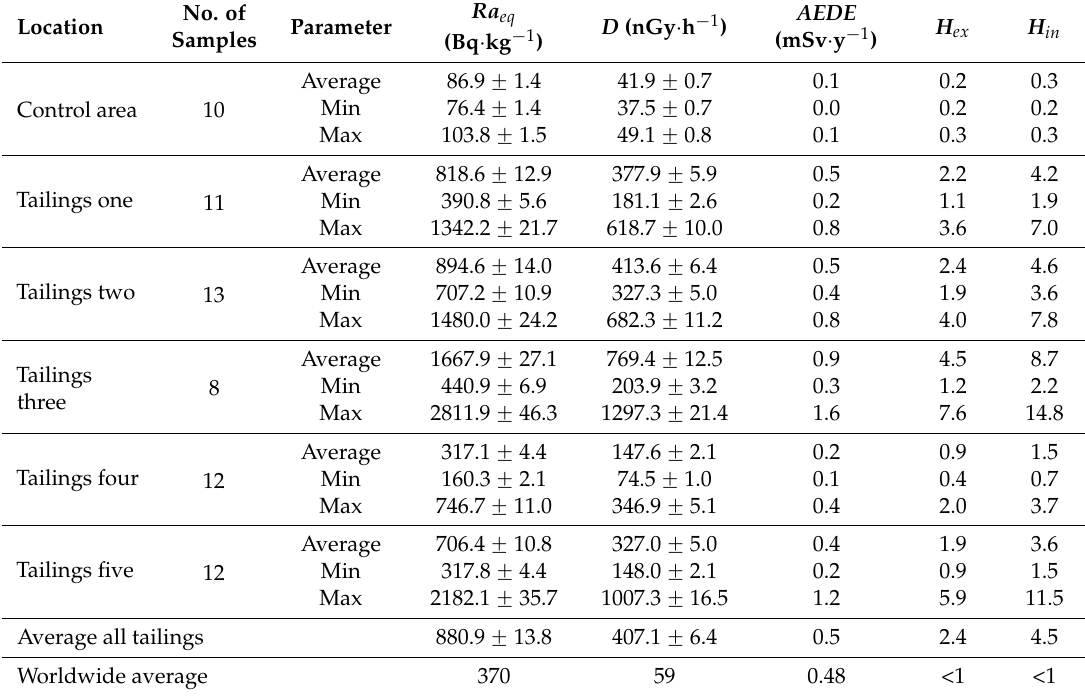
Table 3. Calculated Radium Equivalent Activity ( Ra eq ), Absorbed Dose Rate in air ( D ), Annual Effective Dose Equivalent ( AEDE ), External Hazard Index ( H ex ) and Internal hazard Index ( H in ) of soil samples from the mine tailings and from the control